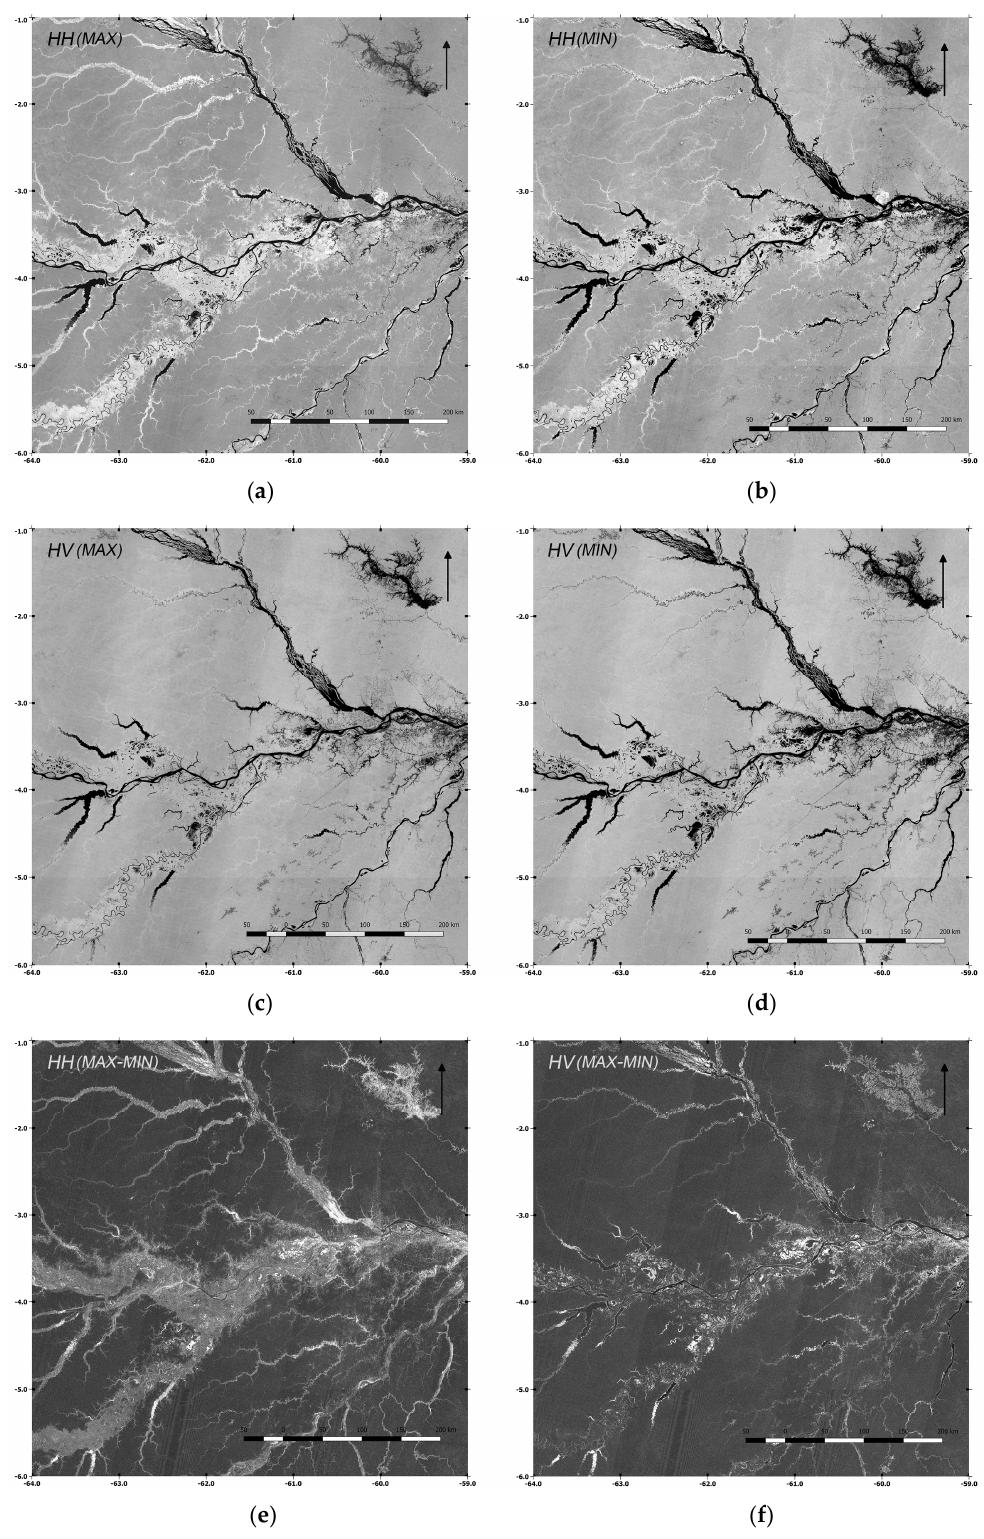
Figure 3. Statistical images derived from ALOS-2 PALSAR-2 ScanSAR cycles for the 2016/2017 flood season. ( a ) Maximum HH-pol backscatter image. Inundated vegetation can be seen as very bright pixels. ( b ) Minimum HH-pol image. ( c ) Maximum HV-pol image. ( d ) Minimum HV-pol image. ( e ) HH-pol di ff erence (MAX–MIN) image. ( f ) HV-pol di ff erence (MAX–MIN) image. Areas exhibiting large seasonal variations in backscatter appear bright in ( e ) and ( f ). ( ©